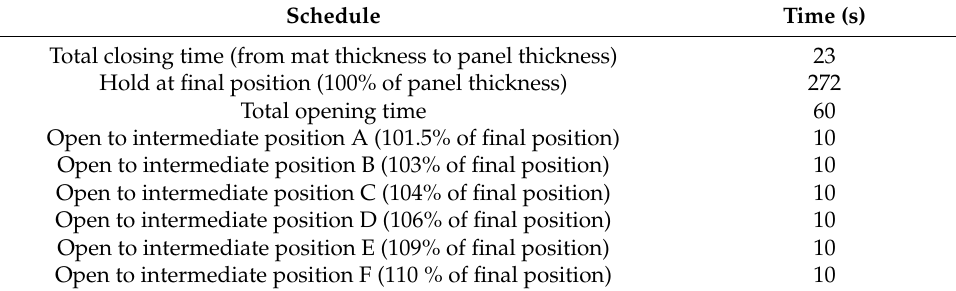
Table 2. One-step pressing